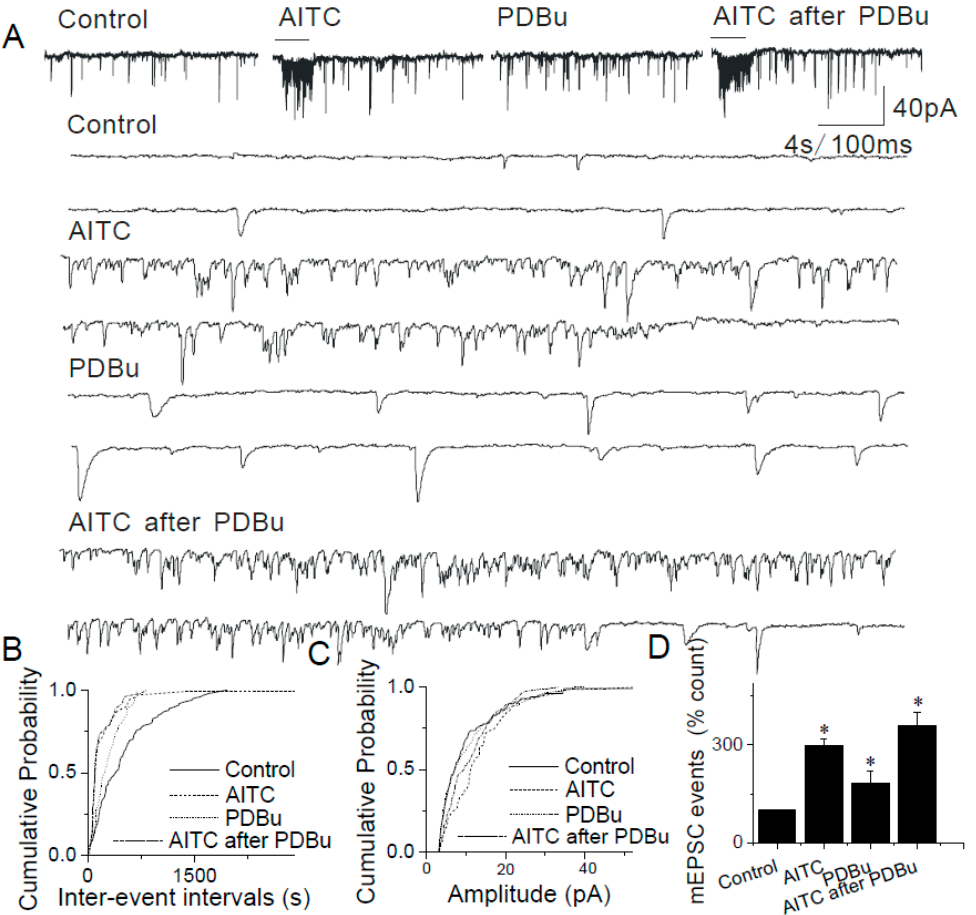
Figure 7. Interaction between AITC and PDBu in the NTS. ( A ) Application of AITC (200 µ M) increases the frequency of mEPSCs and this action is enhanced by incubation in 3 µ M PDBu. Synaptic events are shown at a higher time resolution below. ( B ) The cumulative probability plots show an AITC-mediated increase in the frequency of synaptic events. These effects are further significantly enhanced by PDBu. ( C ) The increase in frequency of events is not accompanied by a change in the amplitude. ( D ) Summary graphs showing AITC-induced an increase in mEPSC frequency ( n = 9) and potentiation by PDBu ( n = 8). The asterisk (*) represents p < 0.05 as compared to control.